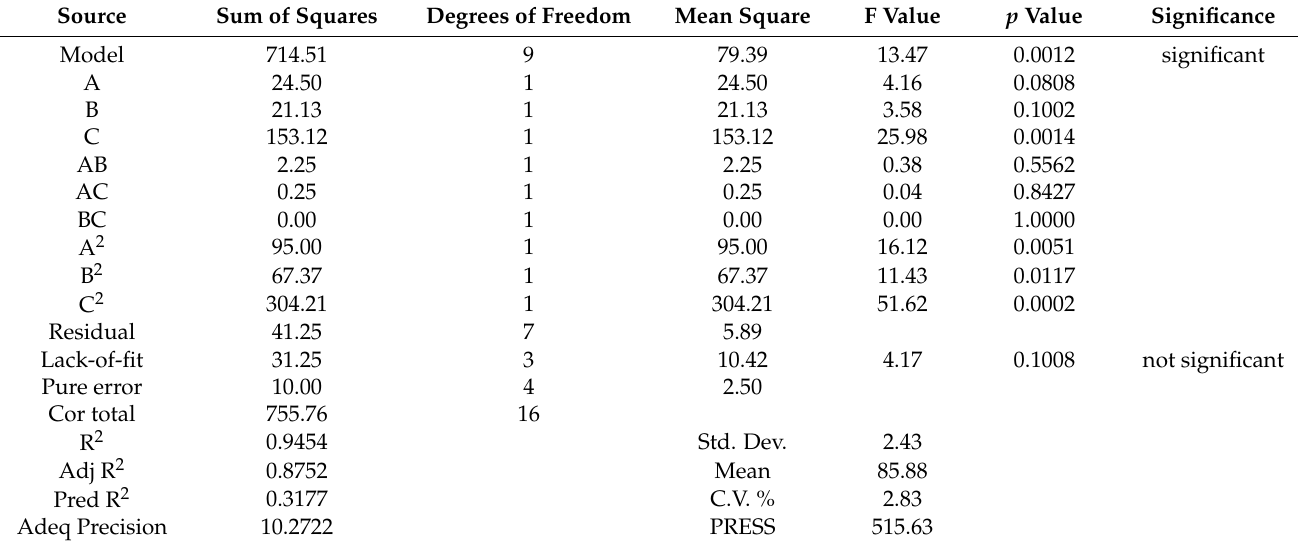
Table 2. ANOVA analysis for the fitted quadratic polynomial